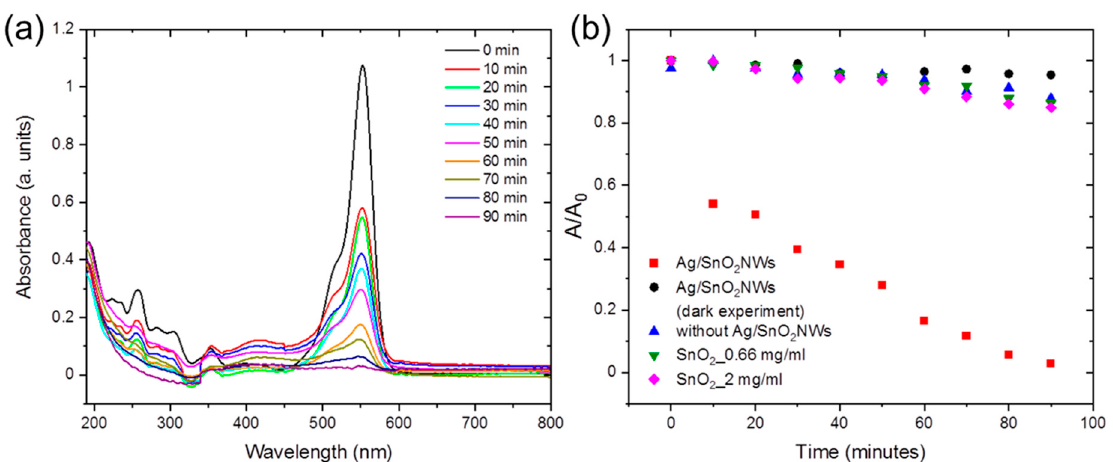
Figure 4. ( a ) The absorbance spectra of rhodamine B with Ag/SnO 2 NWs photocatalyst presence under 450 nm light irradiation. ( b ) The degradation of rhodamine B with 2 mg/mL of Ag/SnO 2 NWs catalyst ( ■ ), with no photocatalyst ( ▲ ), with 0.66 mg/mL ( ▼ ), and 2 mg/mL ( ◆ ) of SnO 2 NPs under 450 nm light irradiation and Ag/SnO 2 NWs without irradiation (dark experiment, ● ).